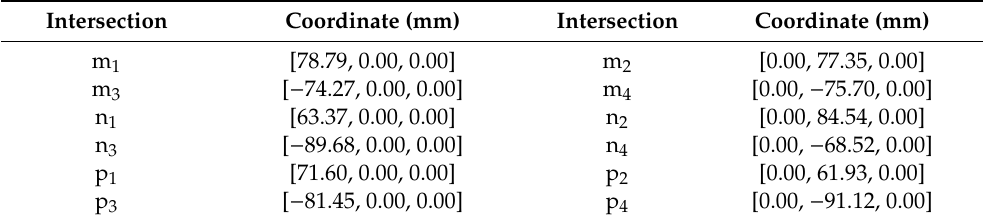
Table 3. The intersection point on CCD1-CCD4 in POSCS.